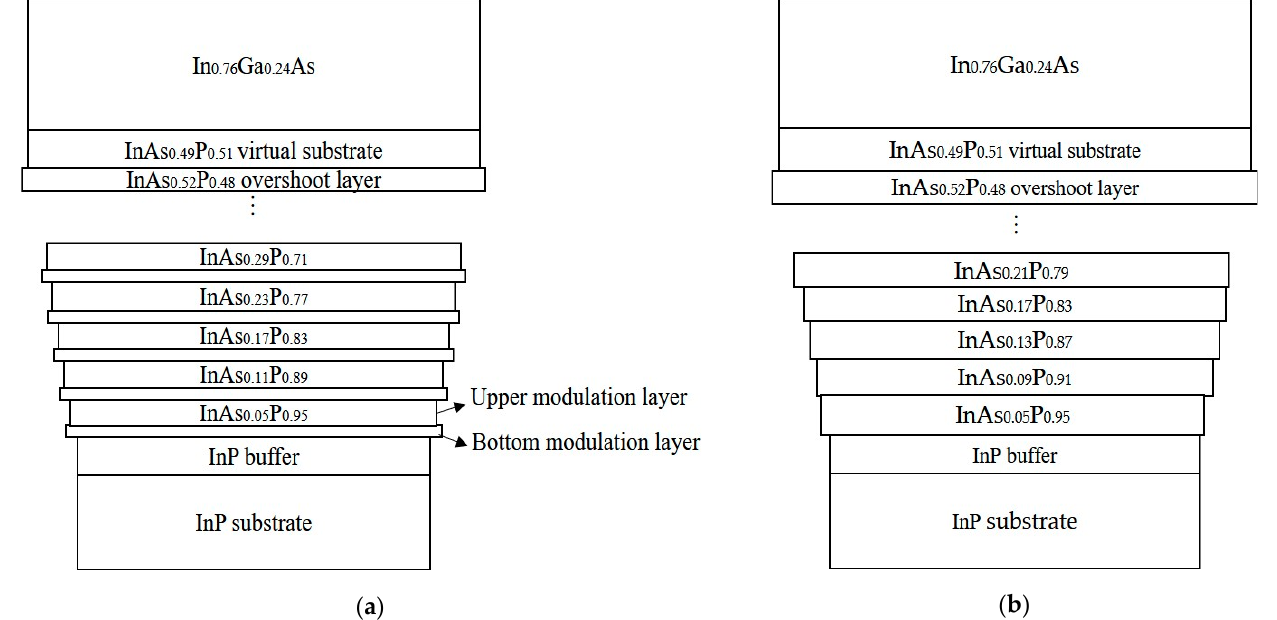
Figure 1. ( a ) Schematic diagram of extended wavelength InGaAs on InP substrate with compositionally undulating step-graded (CUSG) buffer structure (noted as sample A). ( b ) Schematic diagram of In 0.76 Ga 0.24 As on InP substrate with common compositionally step-graded buffer structure (noted as sample B).